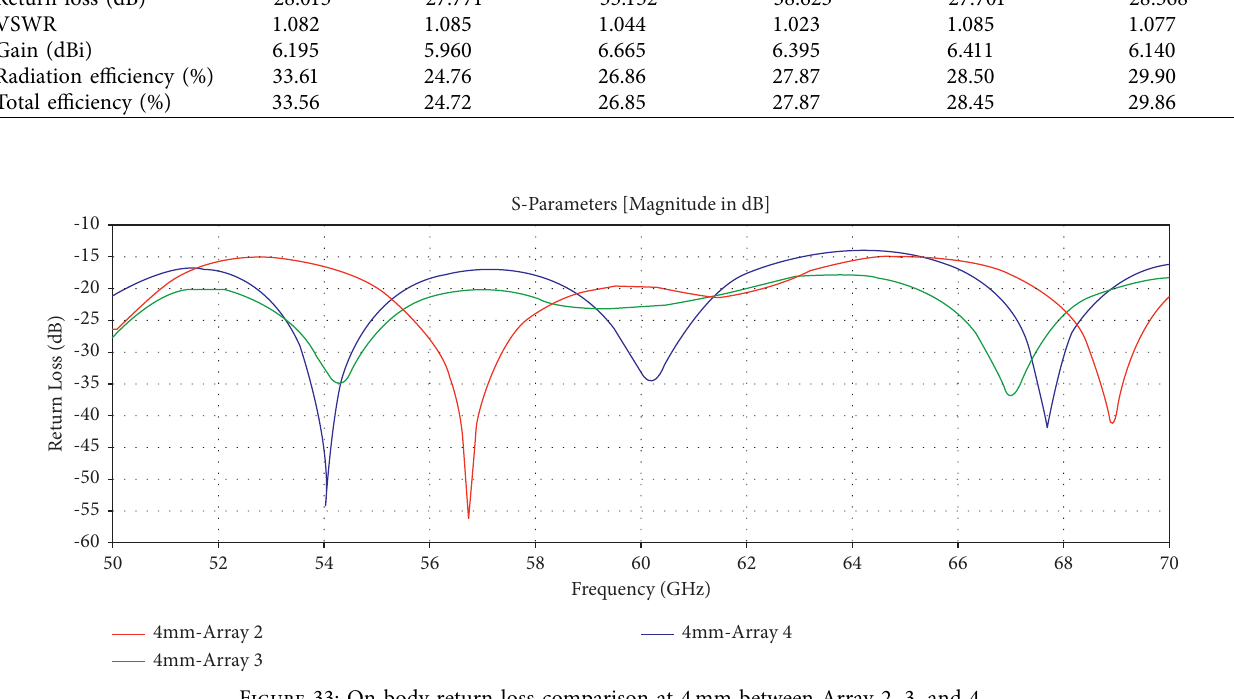
Figure 33: On-body return loss comparison at 4mm between Array 2, 3, and 4.